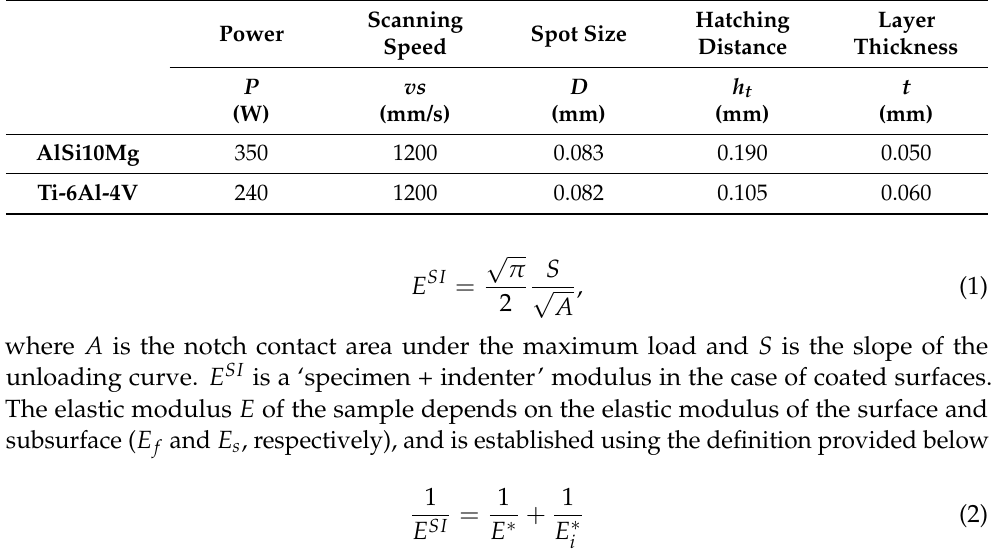
Table 1. Laser scanning parameters used to construct AlSi10Mg and Ti-6Al-4V alloy specimens in a single exposure procedure. Hatching Scanning Spot Size Power Distance Speed